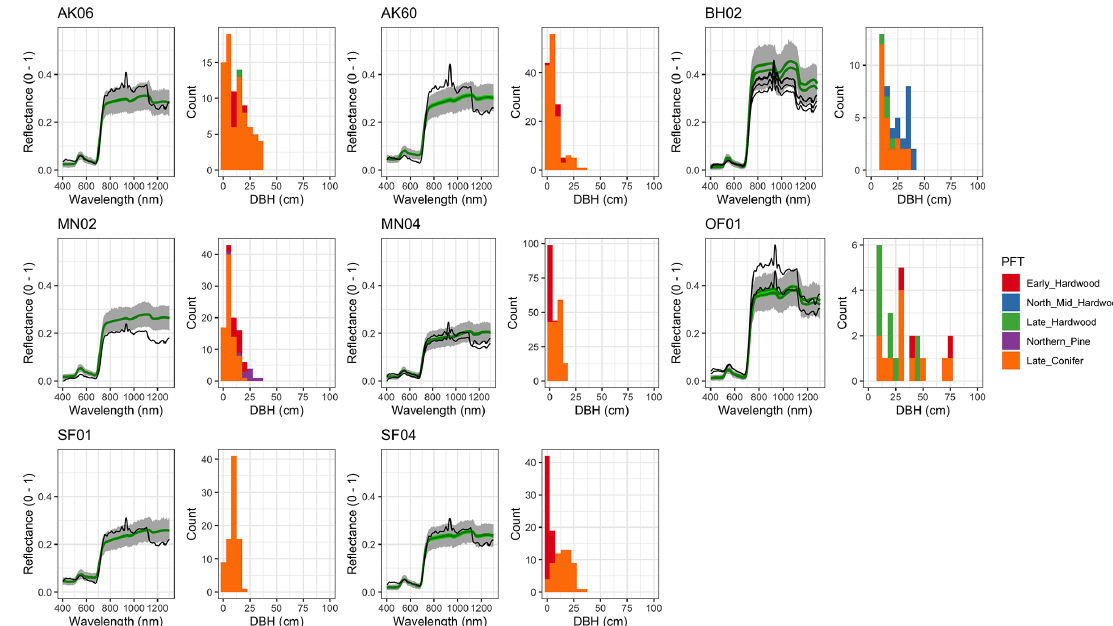
Figure A15. As above but for sites where late conifer trees had the largest mean DBH.